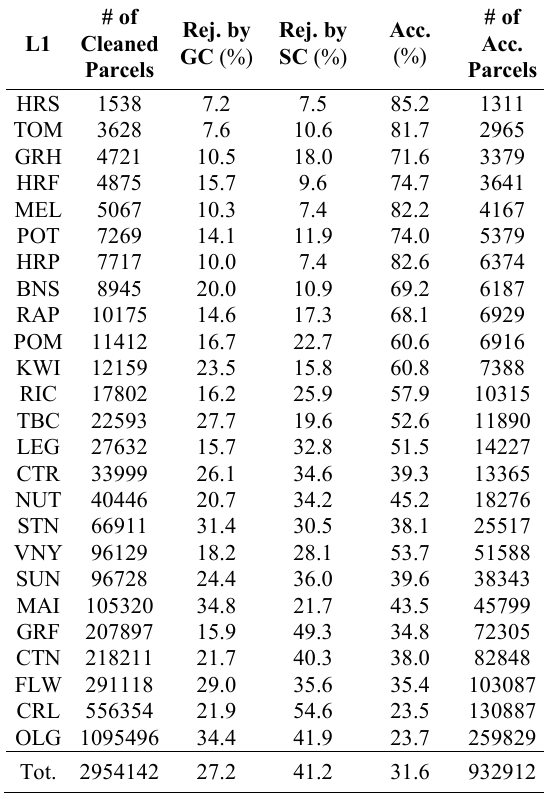
Table 3. Ascending sorted number of cleaned parcels aggregated for the entire country for each Level 1 class and the percentages of rejected (Rej.) parcels by the geometric (GM) and spectral homogeneity (SC) criteria along with the percentage and the number of accepted (Acc.)